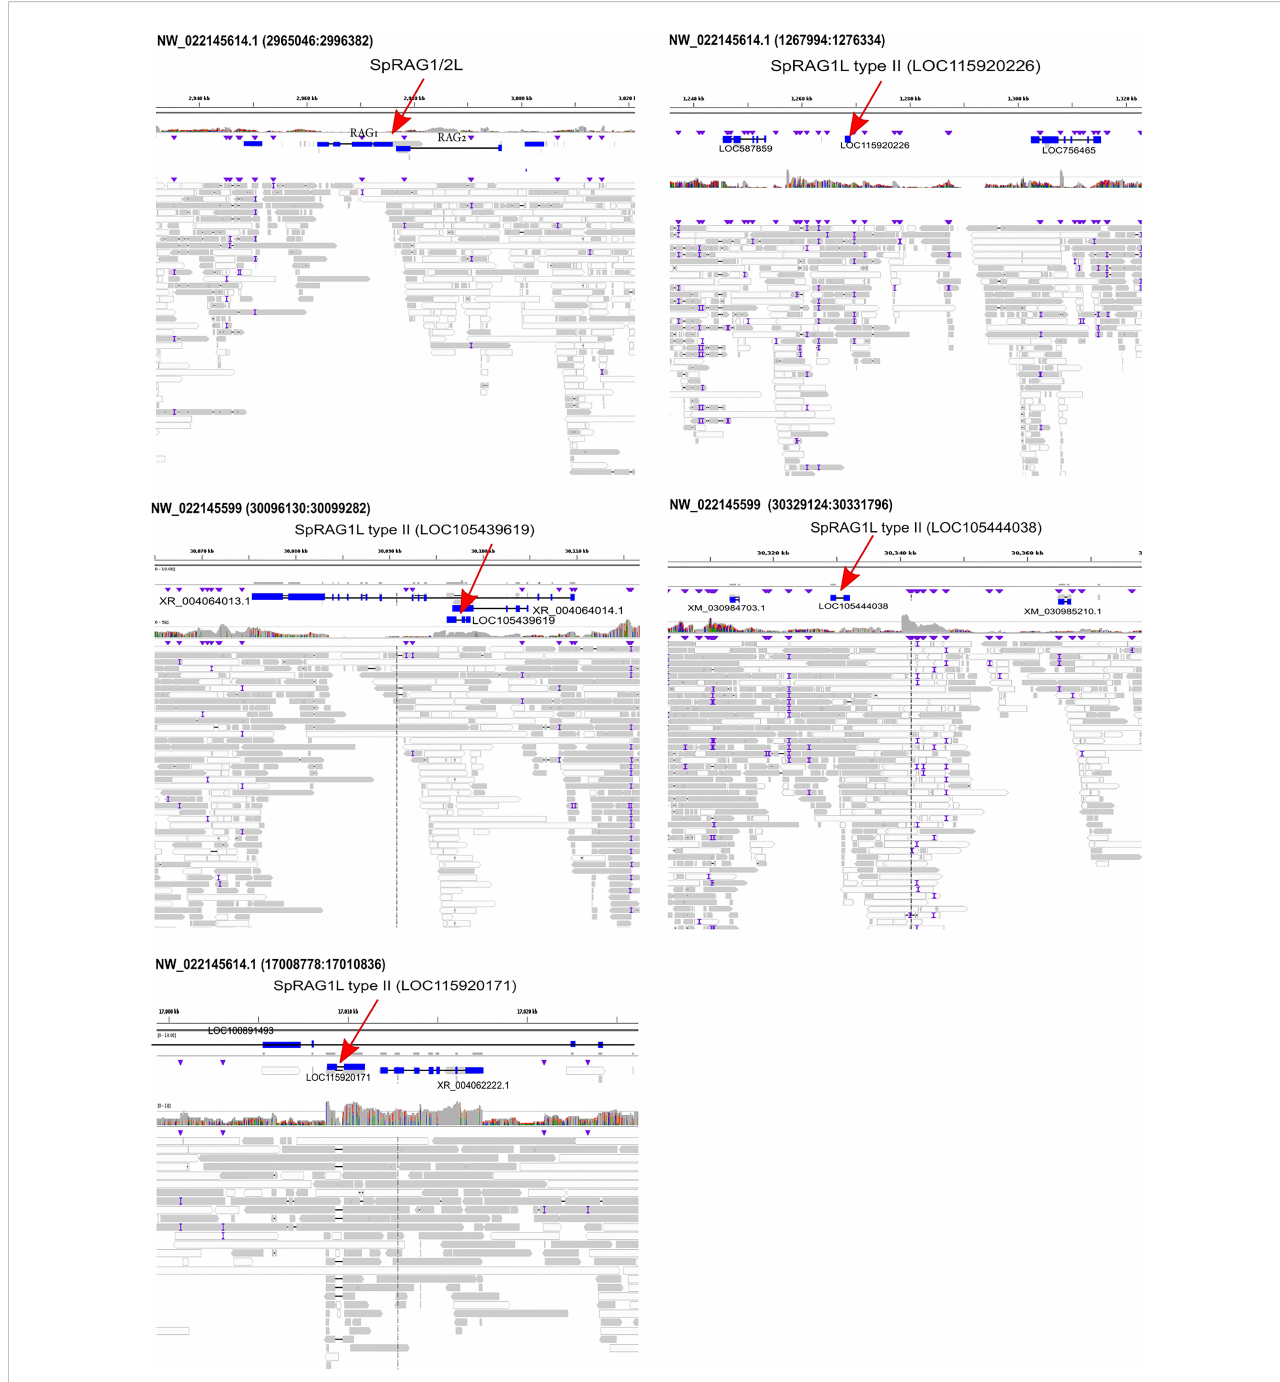
FIGURE 3 SpRAGL genes are immobile in individual sperm and a coelomocyte. The IGV visualized alignment is shown for SpRAG1L type I and II ( LOC115920226, LOC105439619, LOC105444038, LOC115920171 ) genes and their neighboring genes. Red arrows pointing to the RAG1 genes, purple triangles mark the mismatches. Reads with good mapping quality (over 60) are marked in grey, the reads with lower quality mapping are in